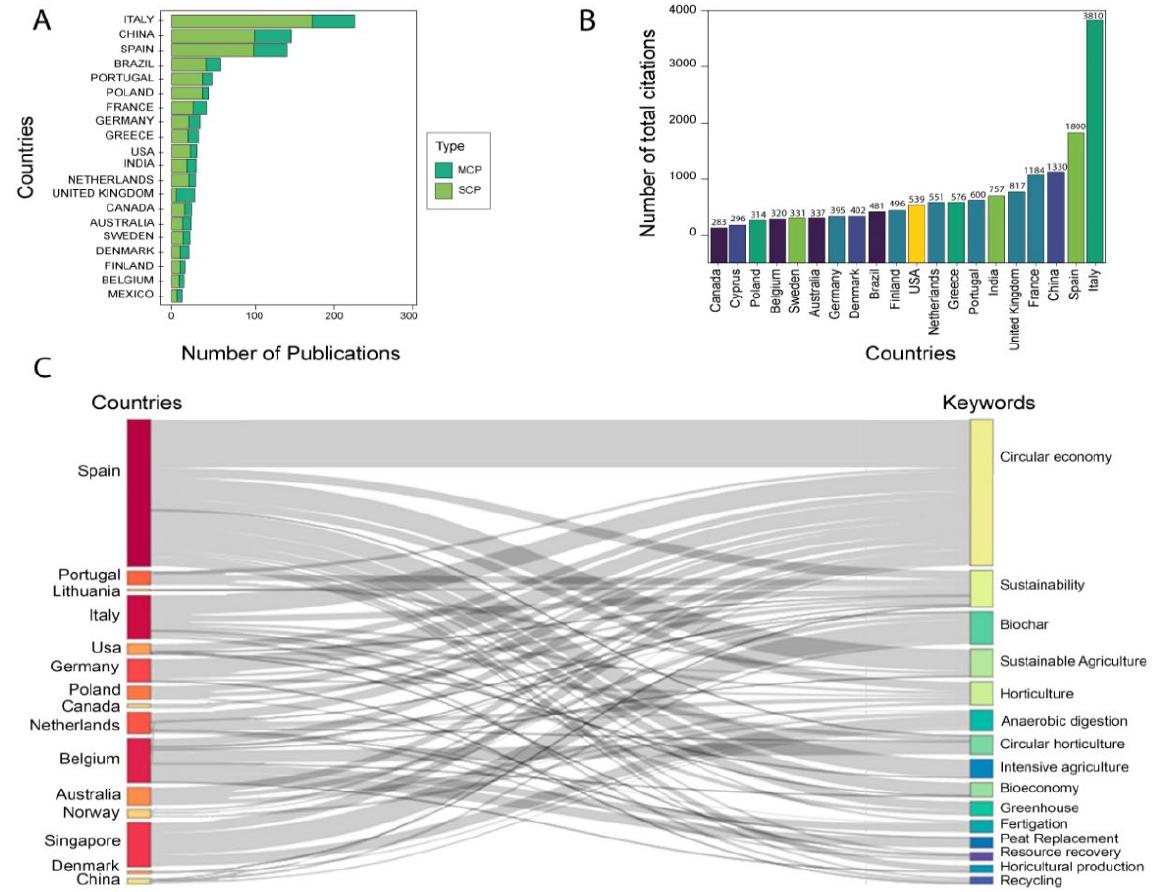
Figure 4. Geographical dynamics of research in circular horticulture. Cooperation between countries ( A ), most cited countries ( B ), and most reported keywords by country ( C ) own elaboration.